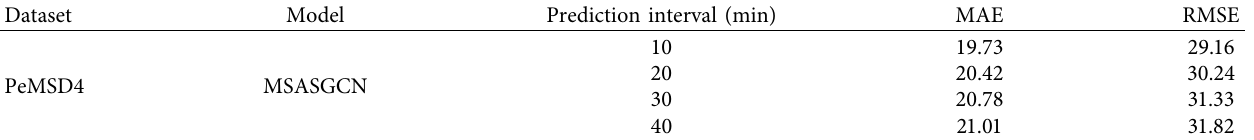
Table 3: Average performance of experiments with different prediction intervals on